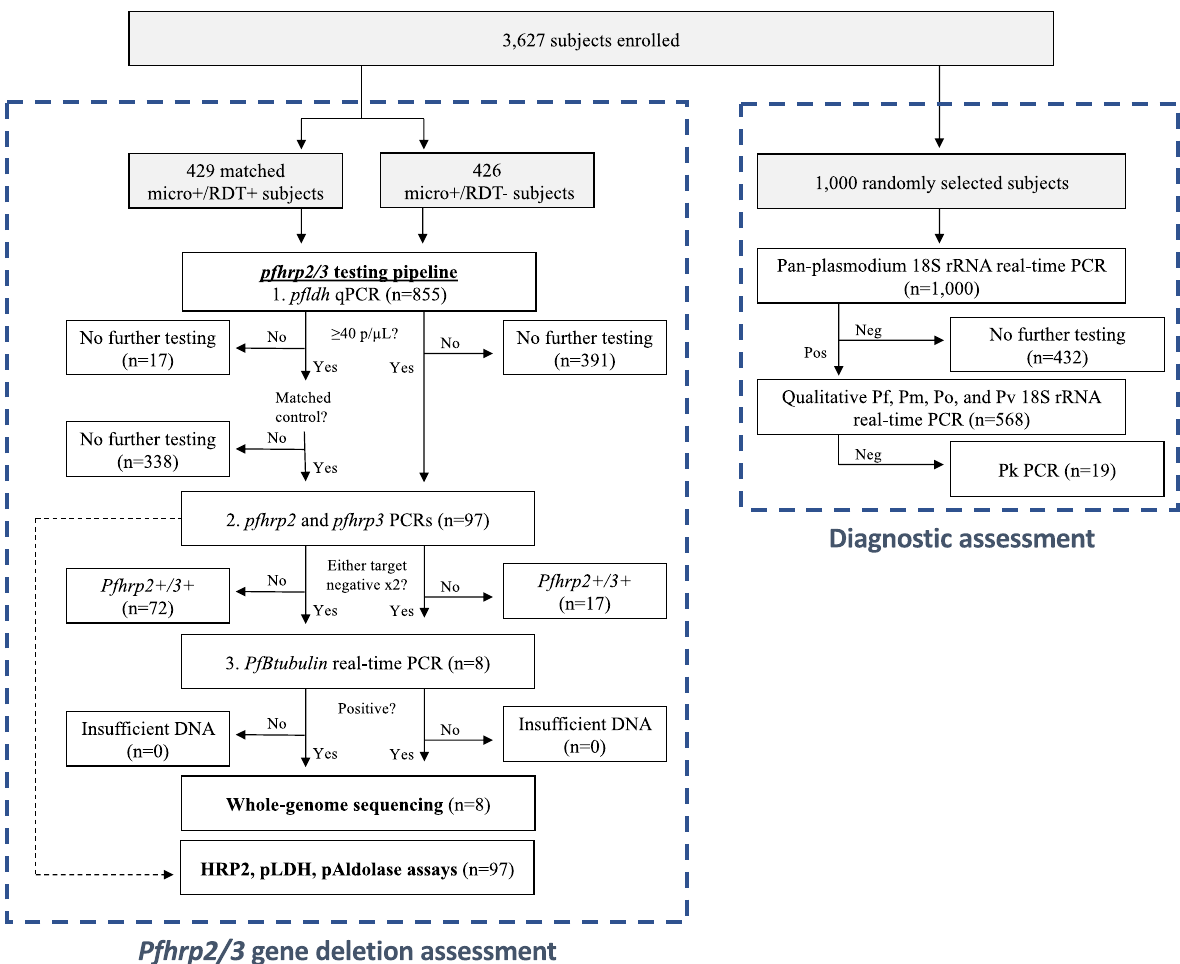
Figure 3. Sample selection for assessment of pfhrp2/3 deletions and diagnostic performance. Pf P. falciparum, Pm P. malariae , Po P. ovale , Pv P. vivax , Pk P.